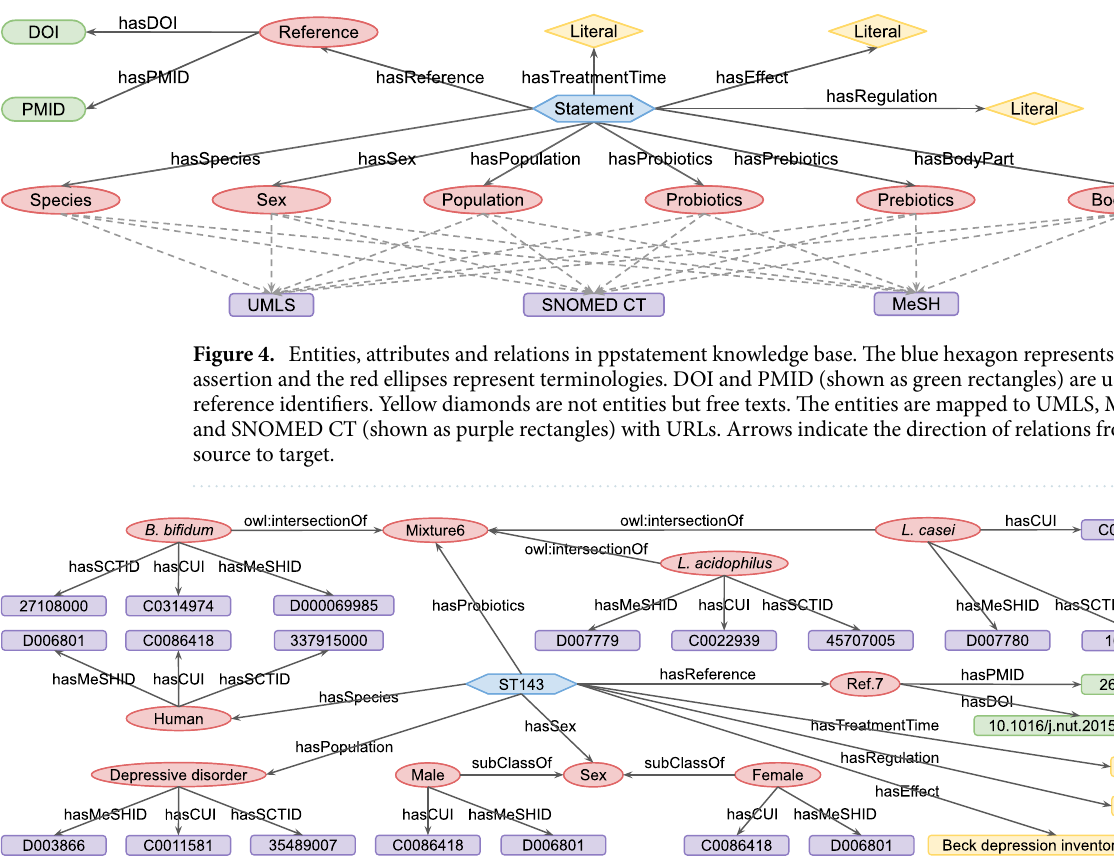
Figure 5. Schematic diagram of statement ST143 extracted from the ppstatement knowledge base. The blue hexagon represents assertion and the red ellipses represent terminologies. Assertion includes the ‘Statement’ (ST143). Terminologies consist of the entities: ‘Species’ (human), ‘Sex’ (male and female), ‘Population’ (depressive disorder), ‘Reference’ (Ref. 7 ) and ‘Probiotics’ ( B. bifidum , L. acidophilus and L. casei ). Yellow rectangles are free texts. DOI and PMID (shown as green rectangles) are used as reference identifiers. Purple rectangles represent the IDs of entities in the UMLS, MeSH and SNOMED CT databases. Arrows indicate the direction of relations from source to